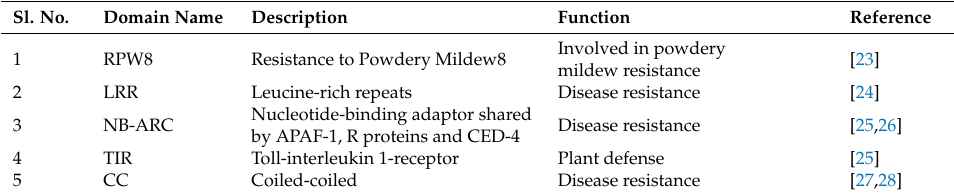
Table 2. Key domains in the 44 watermelon NBS proteins.